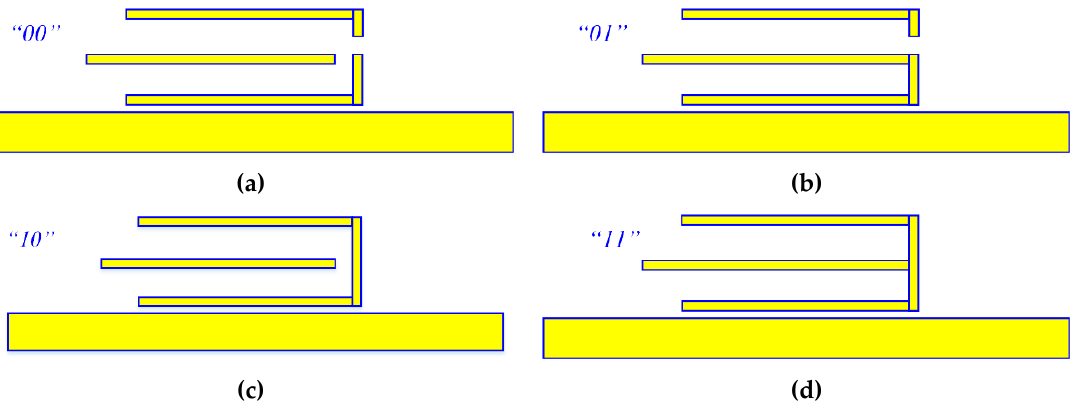
Figure 5. Four possible states for the single proposed resonator: ( a ) S 1 (no frequency), ( b ) S 2 ( f 2 only), ( c ) S 3 ( f 1 only), and ( d ) S 4 ( f 1 and f 2 ). Table 2. Possible states for single resonator.